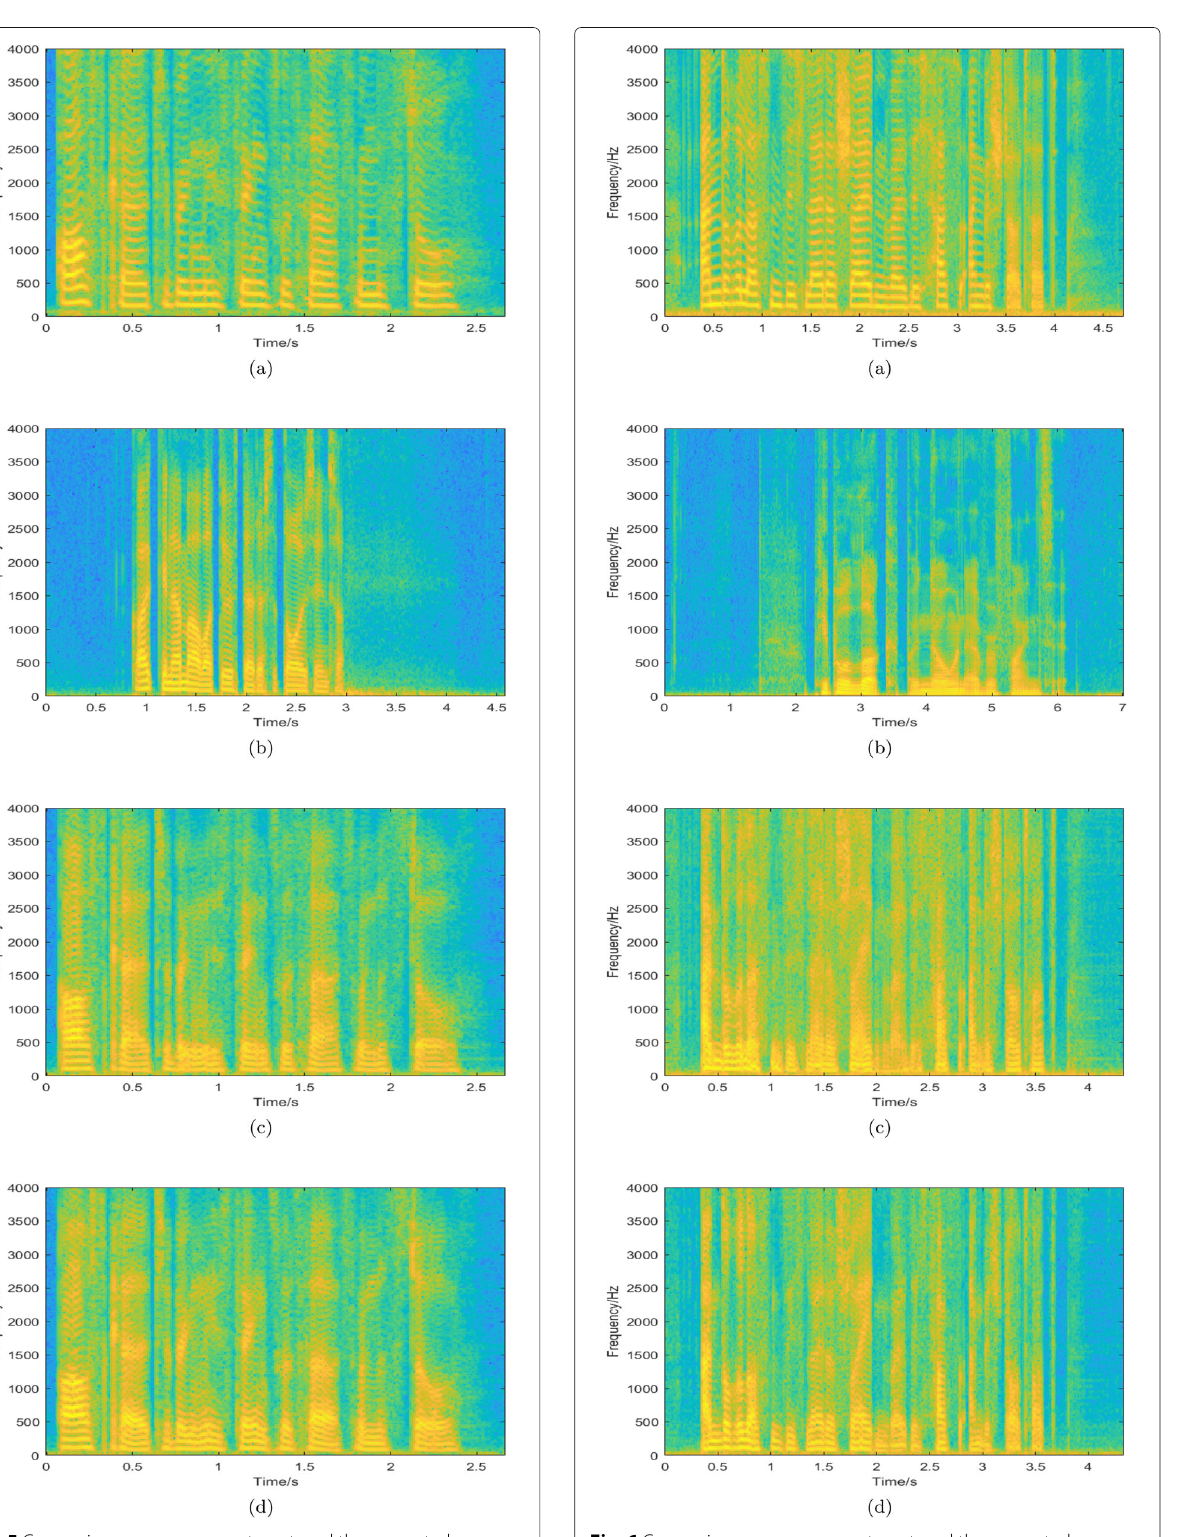
Fig. 5 Comparison among source, target, and the converted spectrograms in cross-lingual scenario(VCTK2VCC). a Source speech. b Target speech. c The converted speech of AGAIN-VC. d The